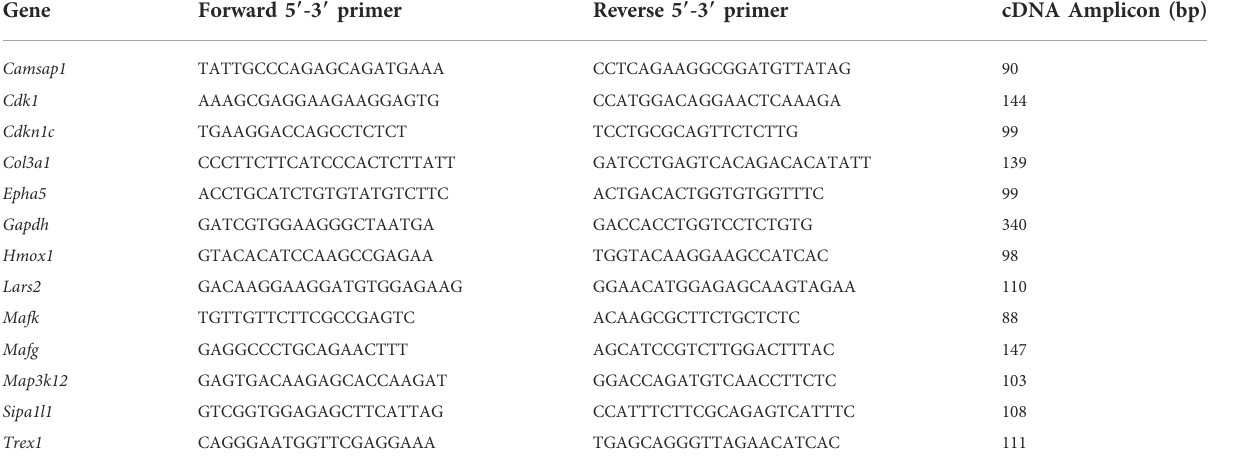
TABLE 2 Primers used in RT-qPCR